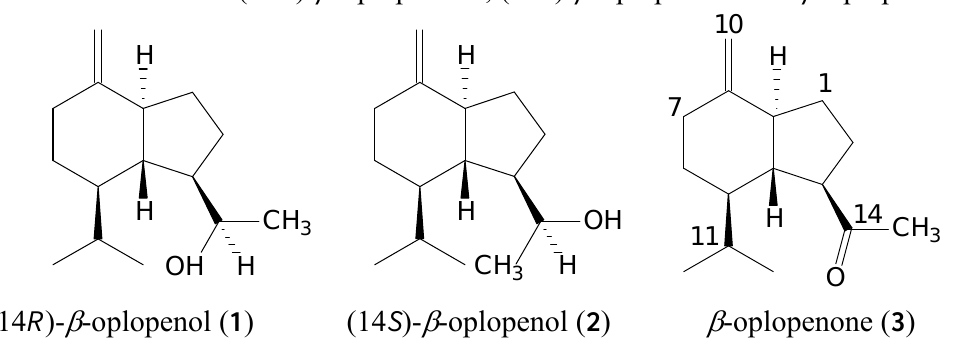
Figure 1. Structures of (14 R )- β -oplopenol 1 , (14 S )- β -oplopenol 2 and β -oplopenone 3